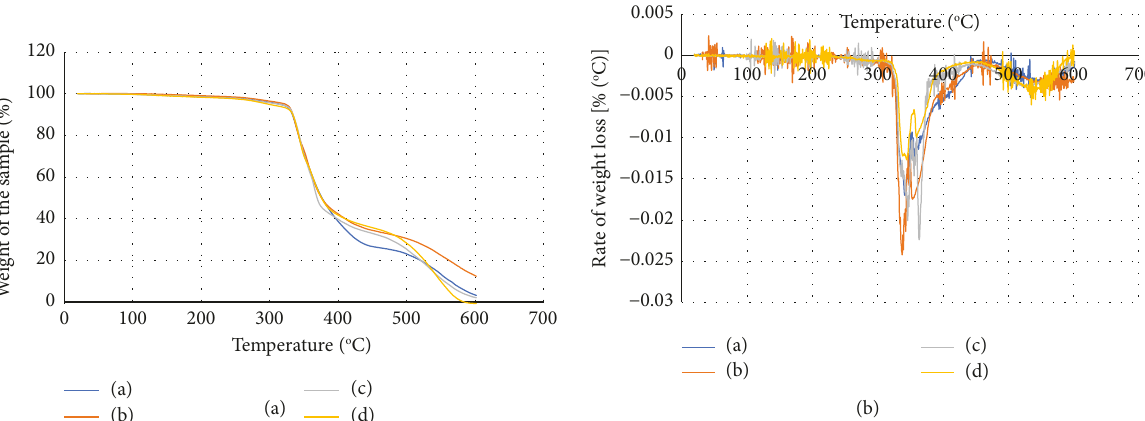
Figure 9: (a) TG and (b) DTG curves of BC fabricated under various sonicating time: 90min (A), 60min (B), 30 min (C), and 15min (D).